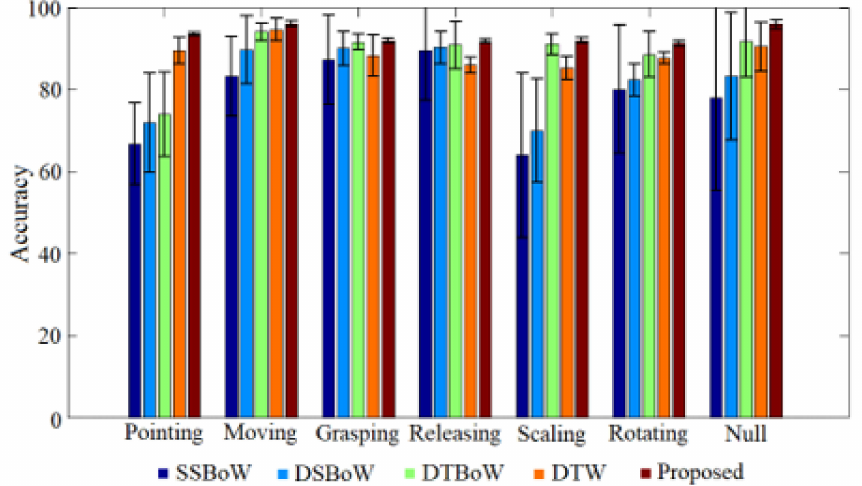
Figure 14. Accuracy of frames recognition in an action unit on Assembly Gesture Video